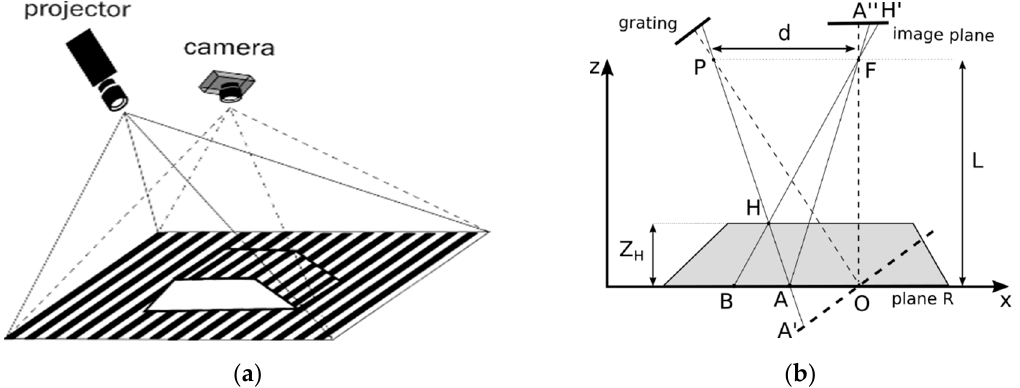
Figure 3. Example of structured light profilometry: ( a ) schemes of the approach and ( b ) geometry of projection and vision systems. Adaptation from [33].